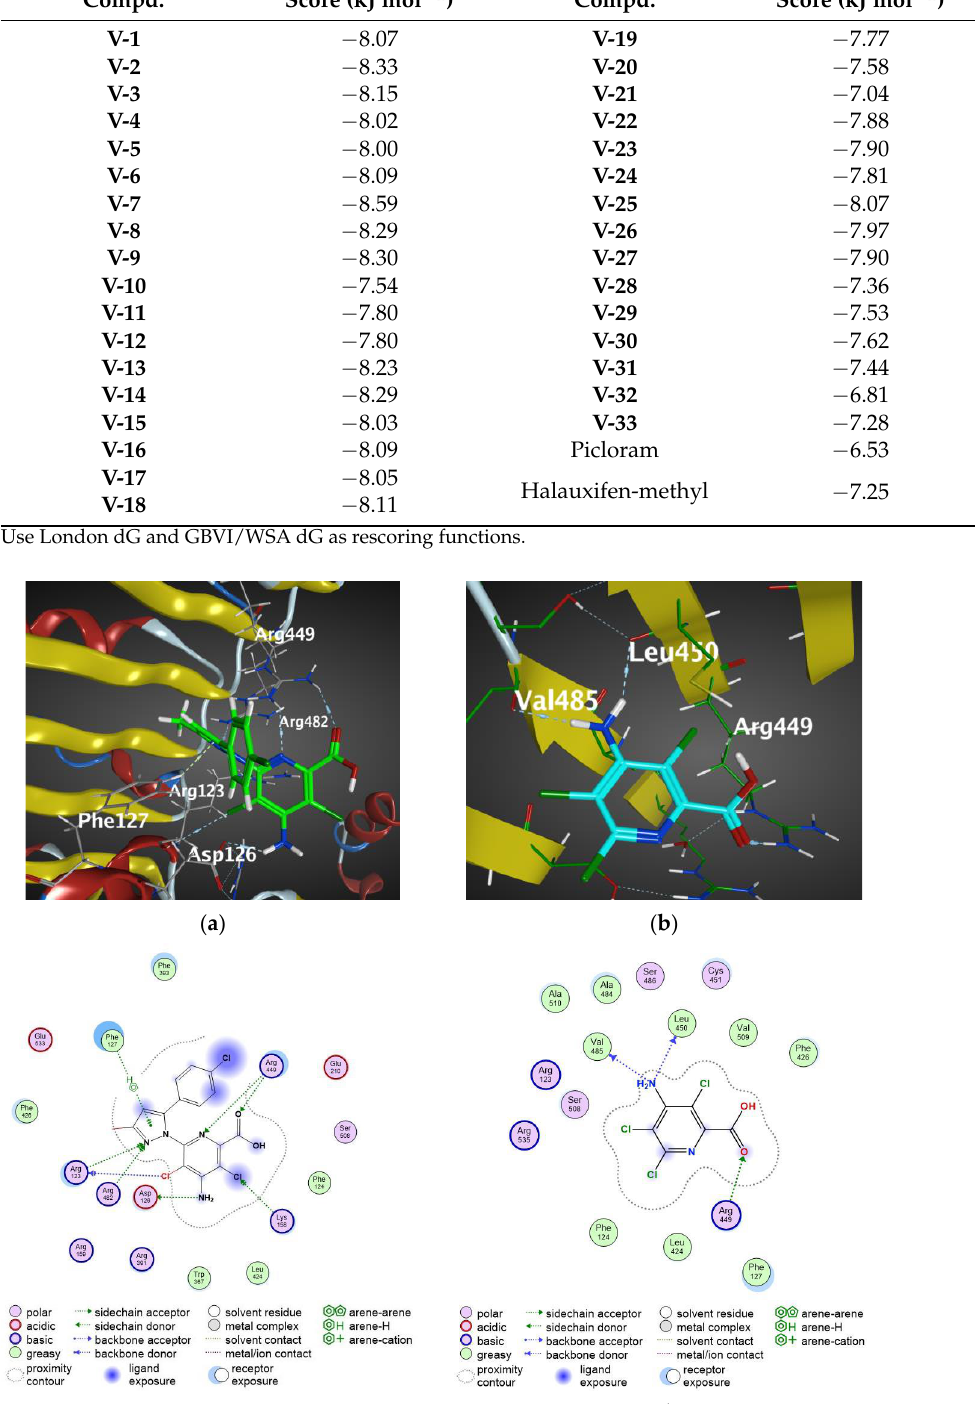
Figure 4. AFB5 exhibits different auxin-binding affinities to compounds. Three-dimensional struc- tures of AFB5 exhibit an almost identical fold with regard to secondary structure arrangements. ( a ) Docking arrangements of compound V-7 to AFB5. ( b ) Docking arrangements of picloram to AFB5. White sticks represent hydrogen atoms, red sticks represent oxygen atoms, blue sticks represent nitrogen atoms and dark green sticks represent chlorine atoms. ( c ) Two-dimensional interaction of compound V-7 to AFB5. ( d ) Two-dimensional interaction of picloram to